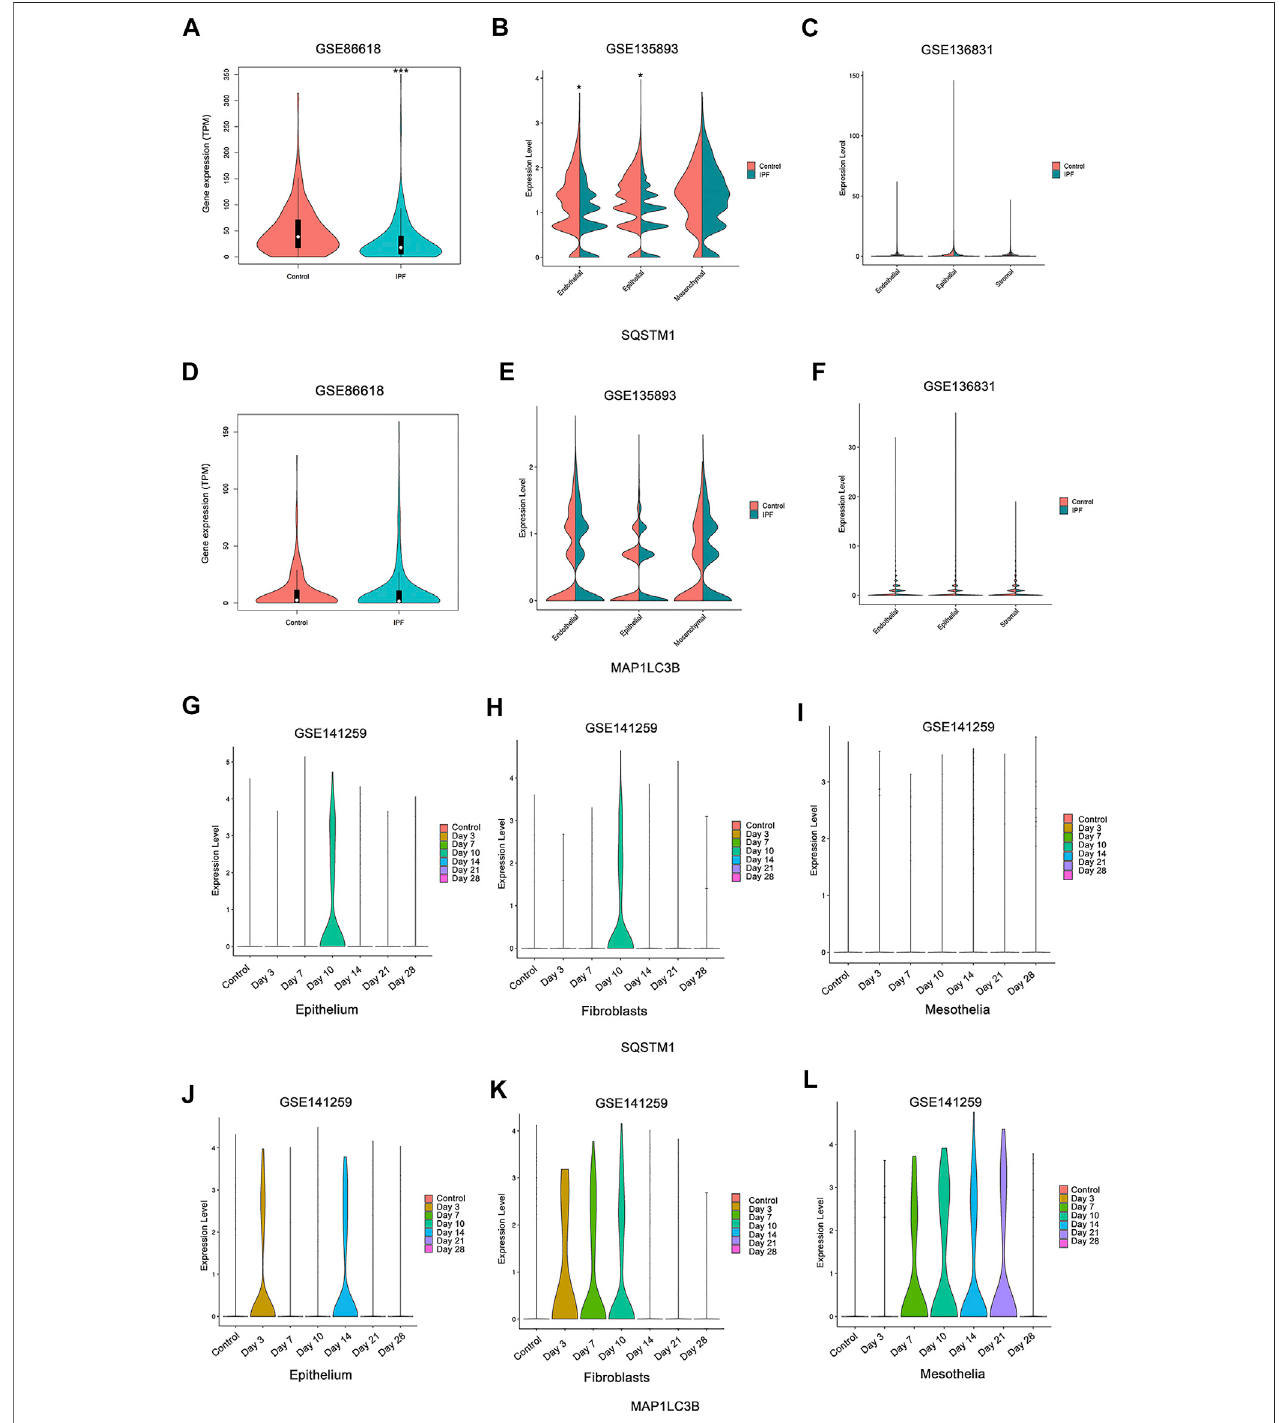
FIGURE7| Expressionofautophagyinsingle-cellsequencingstudies. (A,D) ExpressionsofSQSTM1andMAP1LC3Bwereanalyzedamongidiopathicpulmonary fi brosis (IPF) patients and the health from NCBI Gene Expression Omnibus (GEO) dataset GSE86618. (B,E) Expressions of SQSTM1 and MAP1LC3B were analyzed among IPF patients and the health from GEO dataset GSE135893. (C,F) Expressions of SQSTM1 and MAP1LC3B were analyzed among IPF patients and the health from GEO dataset GSE136831. (A – C) Expression of SQSTM1. (D – F) Expression of MAP1LC3B, * p < 0.05, *** p < 0.001. (G – L) Expressions of SQSTM1 and MAP1LC3B were analyzed within the indicated cell subtype in pulmonary fi brosis mouse models induced by bleomycin at different stages. Data was from NCBI GEO dataset GSE141259. (G – I) Expression of SQSTM1. (J – L) Expression of MAP1LC3B.